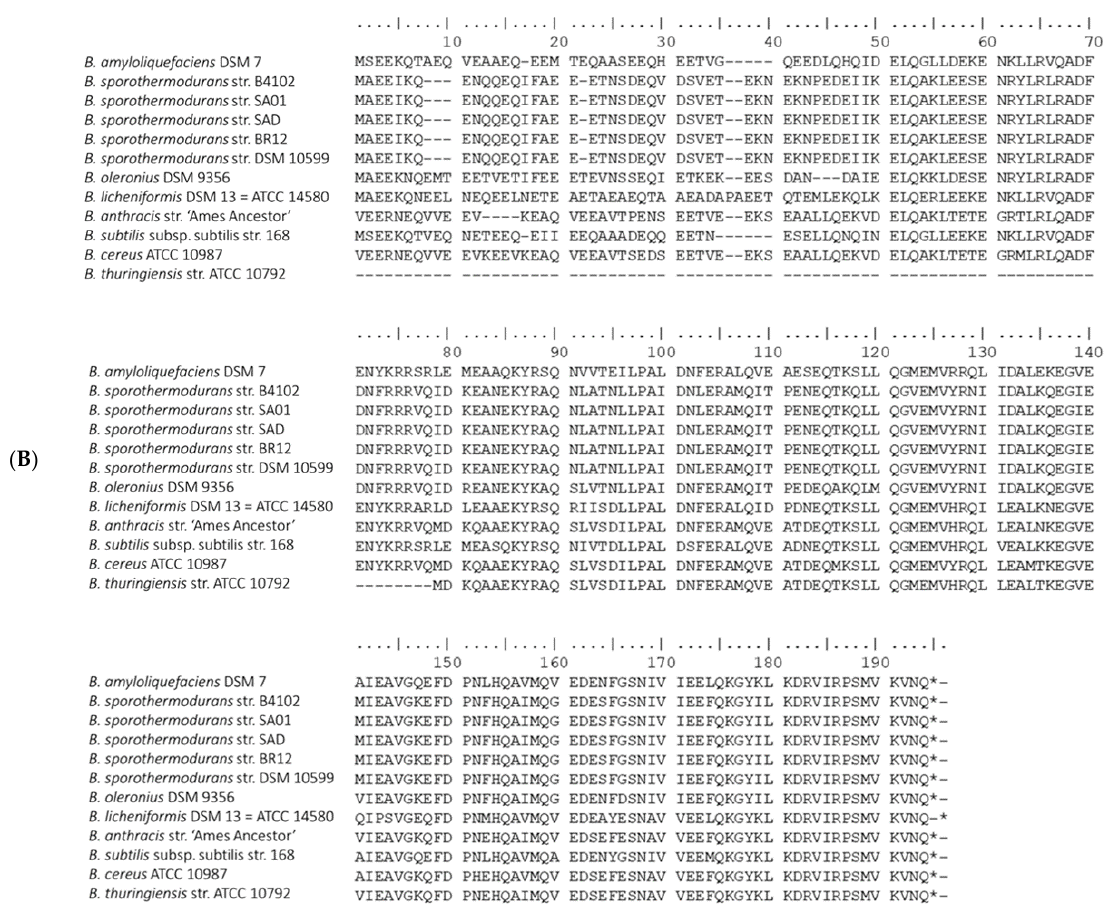
Figure 6. Nucleotide sequence alignment of the heat shock protein, GrpE ( A ), showing conserved regions, and the sequence alignment of its corresponding amino acid sequence ( B ), indicating the e ff ects of the various mutations of the nucleotides on the protein sequence. Sequences were aligned with BioEdit v. 7. ( A , B ) were divided into four and three sections, respectively, to aid